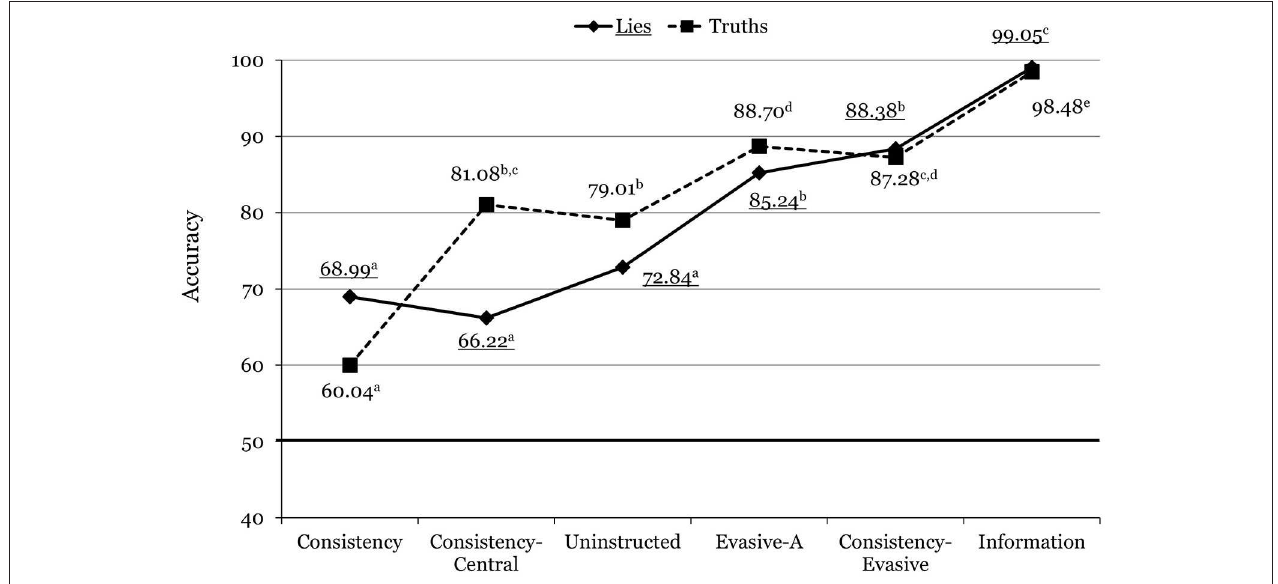
FIGURE 1 | Mean accuracy rates across the different conditions in Experiment 1. For each line, means with different superscripts differ significantly from each other. Underlined values correspond to